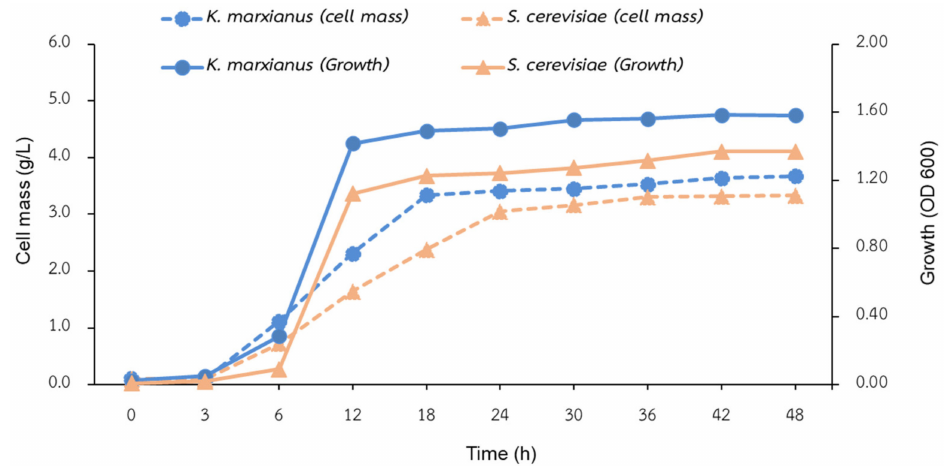
Figure 1. Pilot-scale production profiles of K. marxianus TISTR 5925 and S. cerevisiae Kyokai NO. 9 in a 10 L bioreactor.